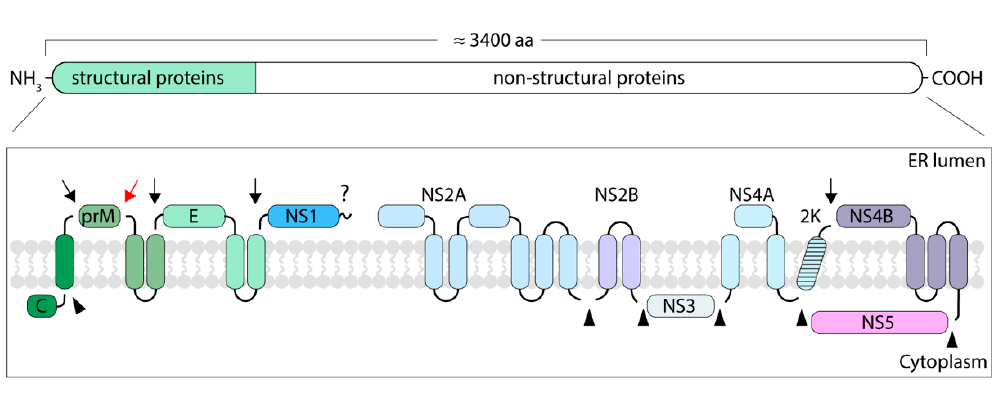
the E-M dimer at neutral pH (wwPDB: 5O6A). Zoom in captions show pH-sensing histidines in detail.